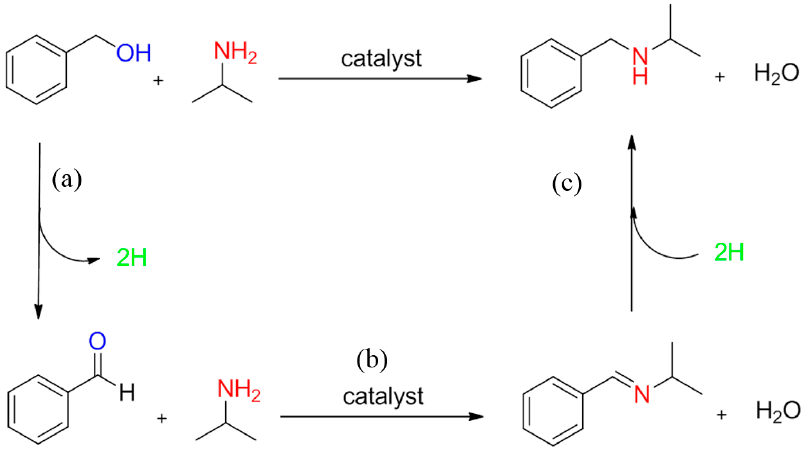
Scheme 1. Accepted mechanism of N -alkylation of isopropylamine with benzyl alcohol.